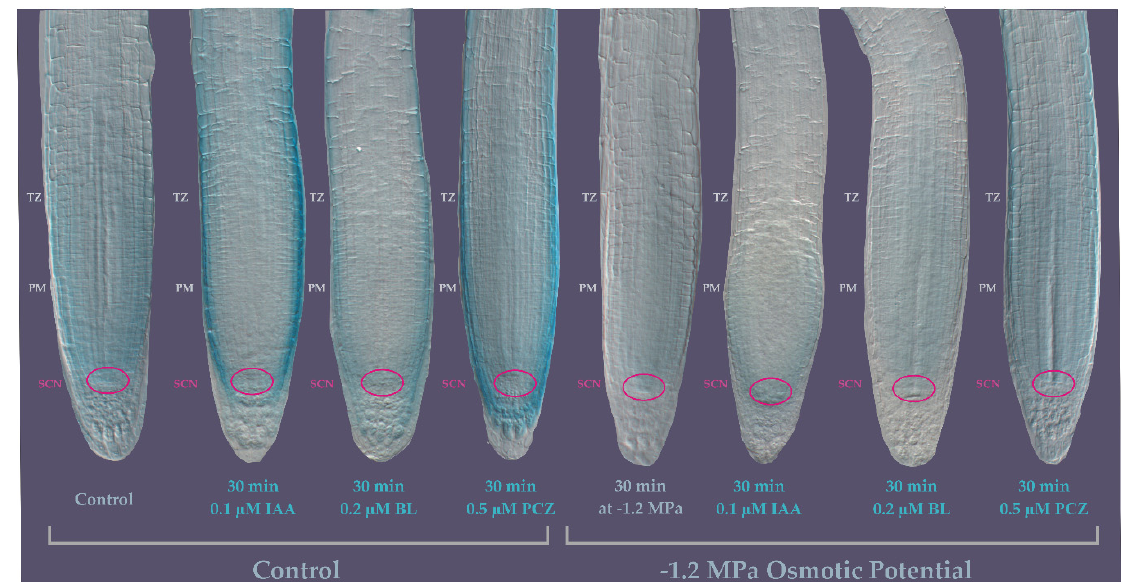
Figure 6. Expression patterns of TTL1 Arabidopsis primary root using promoter::GUS analysis in response to osmotic potential and hormones. pTTL1::GUS roots grown in control conditions showing GUS signal localized to the stem cell niche (SCN) and the proximal meristem (PM) epidermis, cortex, endodermis and stele. pTTL1::GUS roots exposed during 30 min to control medium supplemented with 0.1 µM IAA showing GUS signal localized in the epidermis. pTTL1::GUS roots exposed during 30 min to control medium supplemented with 0.2 µM BL showing GUS signal in lateral root cap and epidermal cells. pTTL1::GUS roots exposed during 30 min to control medium supplemented with 0.5 µM PCZ showing GUS signal in columella, lateral root cap and epidermal cells. pTTL1::GUS roots grown in − 1.2MPa osmotic potential medium showing almost no GUS signal in the SCN and PM. pTTL1::GUS roots exposed during 30 ′ to − 1.2MPa osmotic potential medium supplemented with 0.1 µM IAA showing a pale signal in epidermal and cortex cells in the PM. pTTL1::GUS roots exposed during 30 min to − 1.2MPa osmotic potential medium supplemented with 0.2 µM BL showing a pale GUS signal in the PM. pTTL1::GUS roots exposed during 30 min to − 1.2MPa osmotic potential medium supplemented with 0.5 µM PCZ showing a pale GUS signal distributed similar to the one observed in control conditions without hormones supplemented. n = 15.